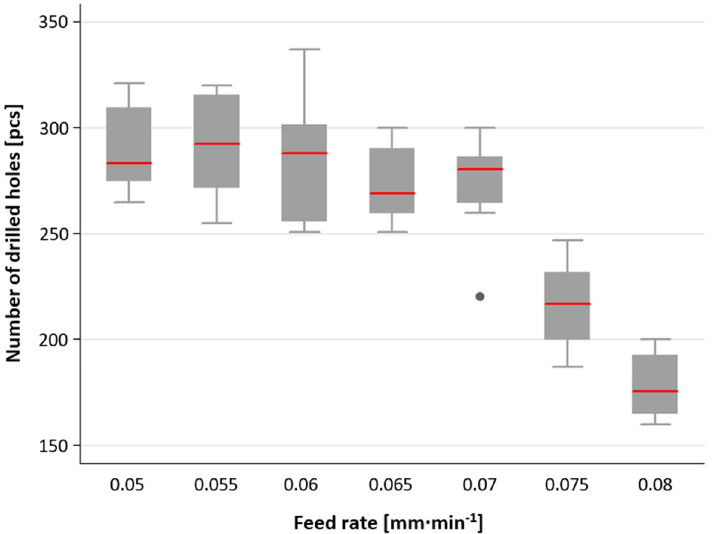
Figure 16. Plotted comparison of the number of holes drilled and the feed rates used in the experiment. Table 6. Results of the comparison of the number of holes drilled up to the moment of tool damage in terms of feed rate.